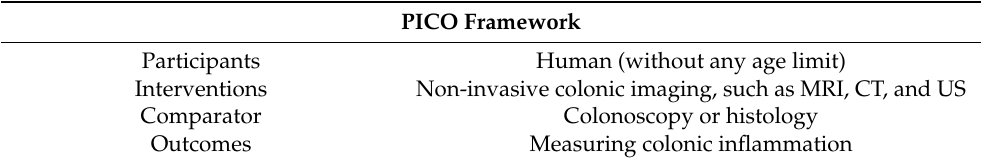
Table 1. Patients, intervention, comparator, and outcomes